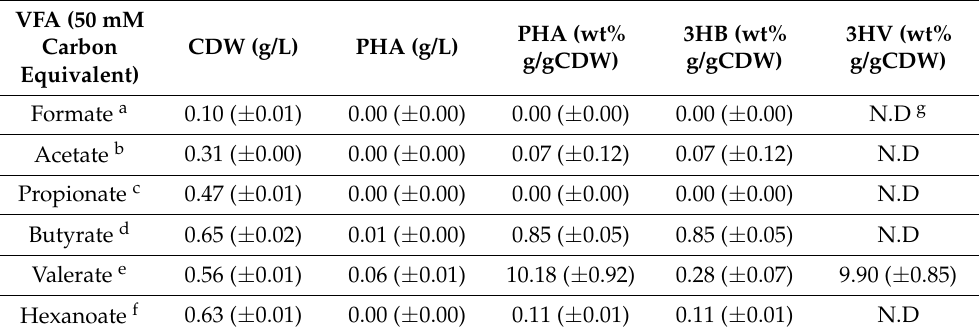
Table 1. Growth and PHA production of C. necator H16 at 72 h post inoculation using 50 mM carbon equivalent VFAs in shake flasks under heterotrophic